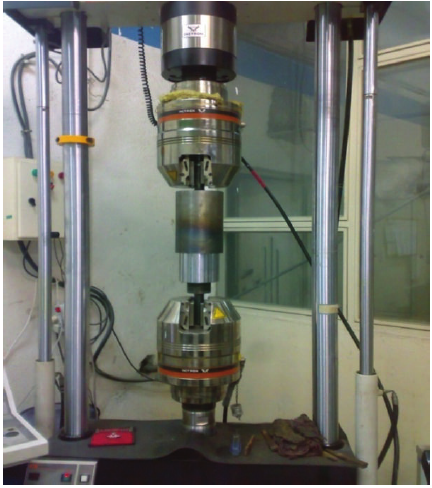
Figure 2: Test setup.